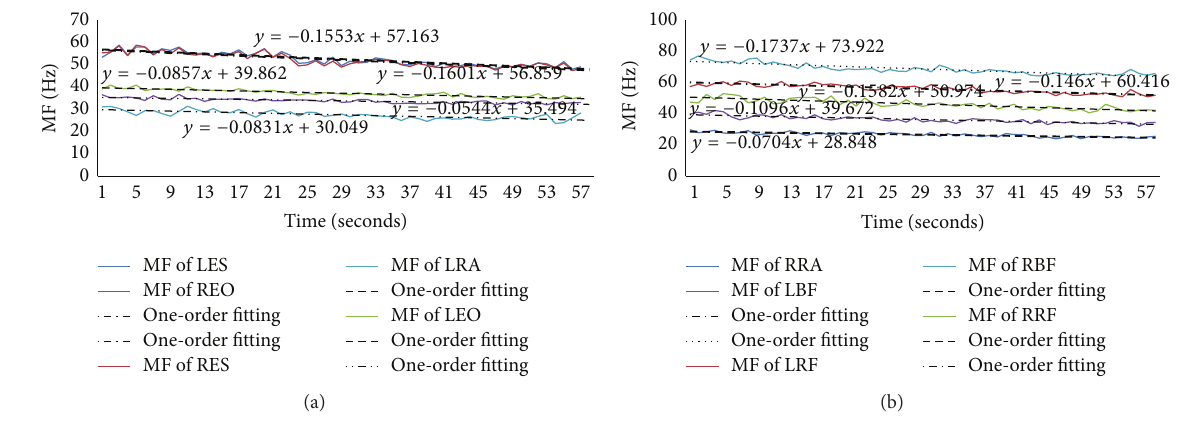
Figure 10: (a) The MF of ES and EO muscles both left and right sides and left side of RA muscle as well as their one-order fitting in the bird-dog exercise. (b) The MF of RF and BF muscles both left and right sides and right side of RA muscle as well as their one-order fitting in the bird-dog exercise.